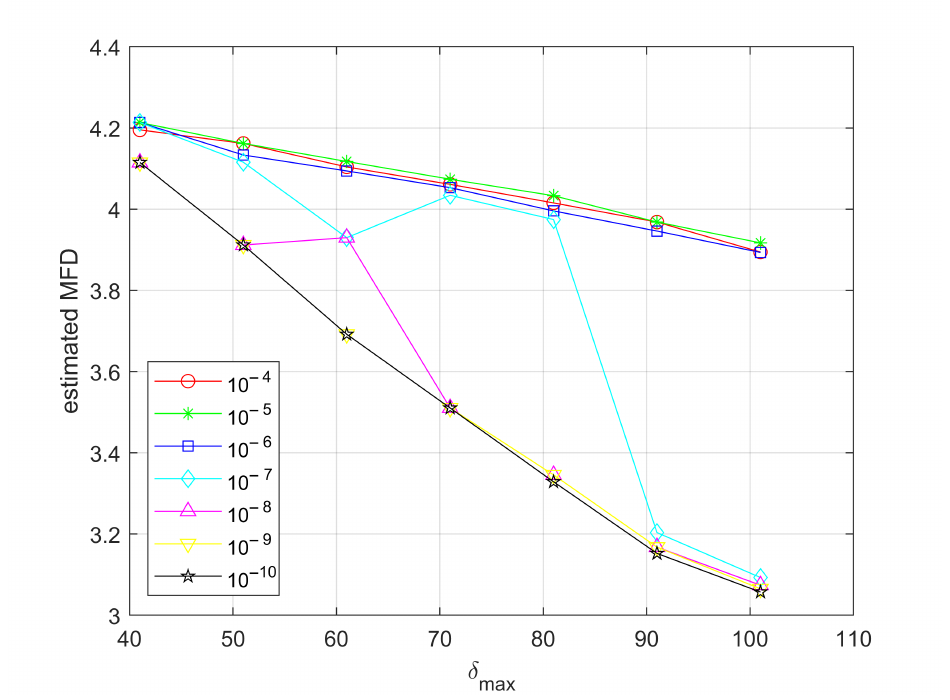
Figure 11. The estimated multi-spectral fractal dimension as a function of δ max for the medium generated complexity ( H = 0.5) multi-spectral fractal